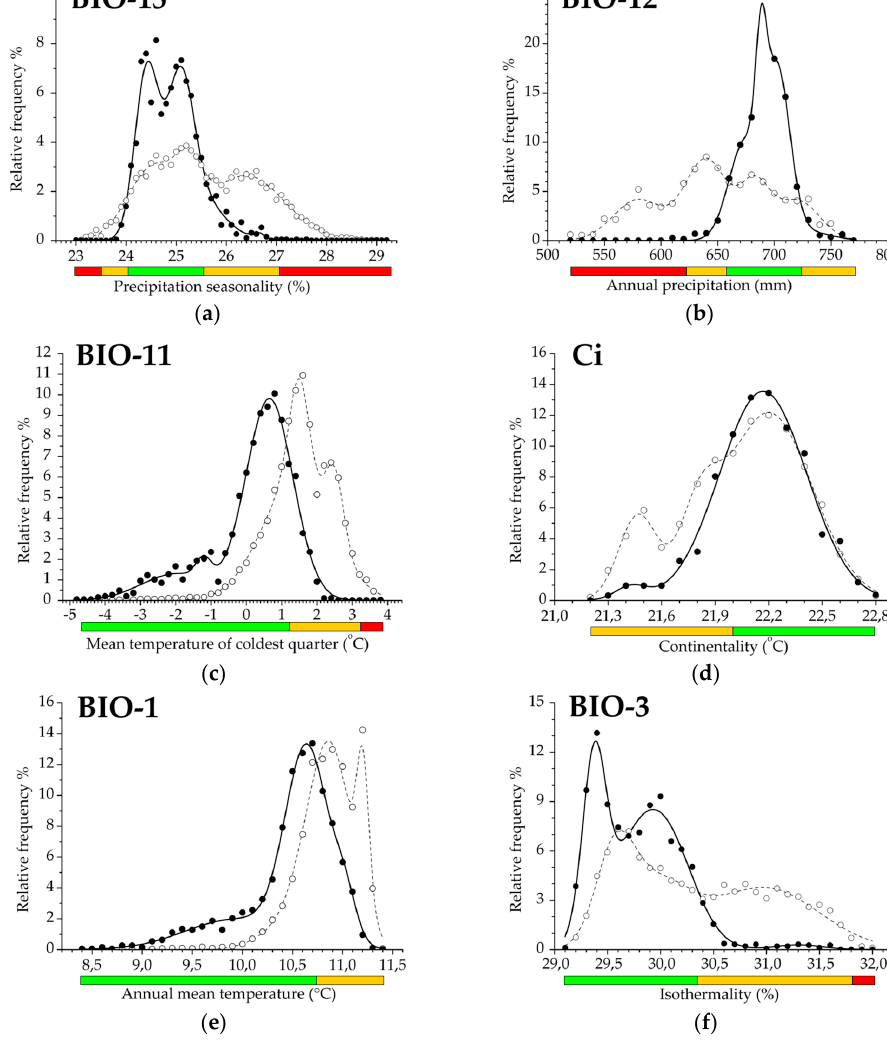
Figure 3. ( a – f ) Climatic response functions of beech forests for selected variables presenting different climatic trait patterns and modality, which differ in the number and position of decay (D) and exclusion (E) ranges (prevalence range is a regular element). ( a ) Response pattern with double decay and exclusion; ( b ) response pattern with double decay; ( c ) response pattern with complete but single response functions; ( d ) response pattern with single decay; ( e ) response pattern with single decay and dominant prevalence function; ( f ) response pattern with single and dominant decay function. Green bar: prevalence function; orange bar: decay function; red bar: exclusion function of the distribution. Filled dots and solid line illustrate relative frequency and fitted curve of beech forests (object), respectively, empty dots and dashed line sign relative frequency and functional curve for the geographic region (reference), respectively. For the dimensions of the functional response ranges see Table 2. Climatic response traits for additional variables are shown in Figure S1.